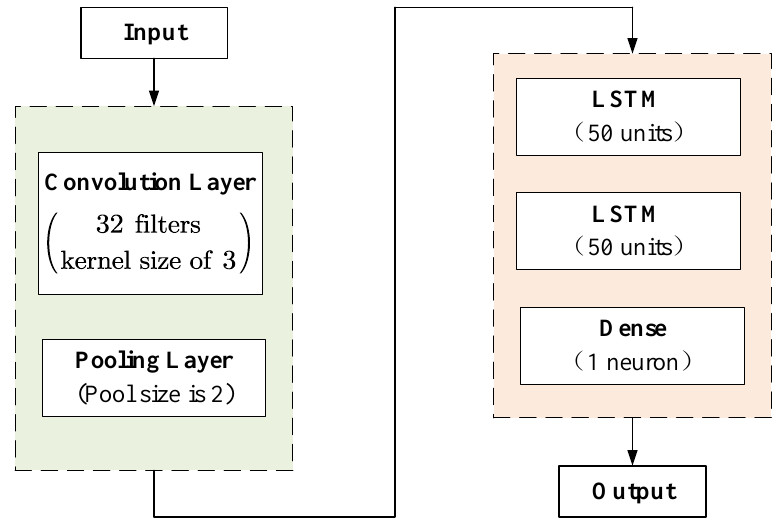
Figure 2. The topology of the CNN-LSTM